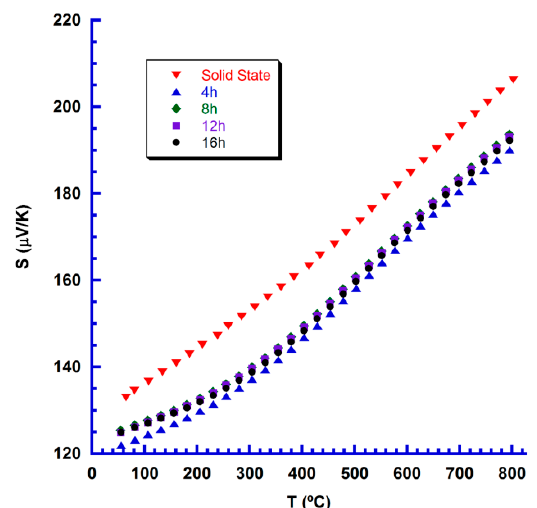
Figure 7. Temperature dependence of the Seebeck coefficient for the different Ca 3 Co 4 O 9+ δ